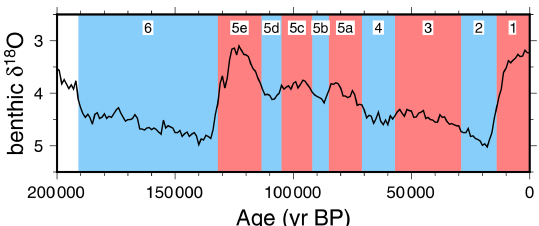
Figure 1. Definition of marine isotope stages. The black line is the LR04 benthic δ 18 O stack (Lisiecki and Raymo, 2005). The MIS stages denoted in red are warm interglacial and interstadial periods, while blue areas are colder glacial and stadial periods. The MIS 5 substage boundaries are from Otvos (2015), while the others are defined by Lisiecki and Raymo